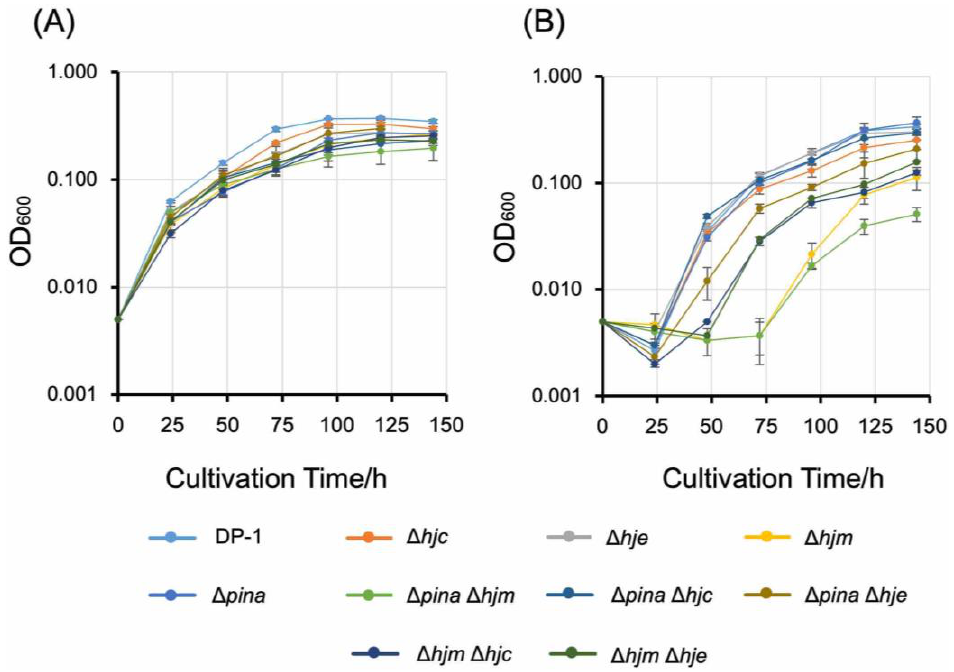
Figure 4. Growth curves of the knockout strains after MMC treatment. Mock treatment ( A ), MMC 240 µM ( B ). Error bars indicate ±SD calculated using three biological replicates.